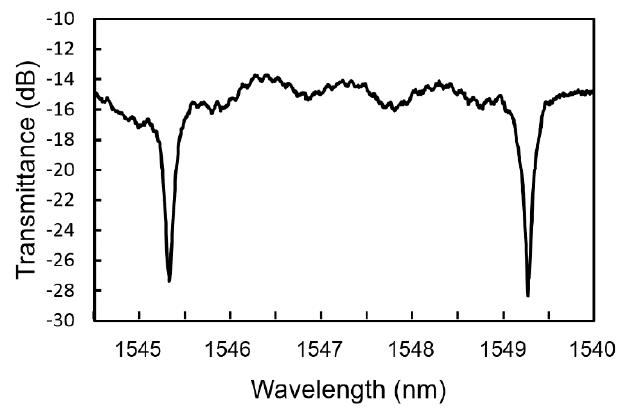
Figure 6. Transmittance spectrum of fabricated Si-MRR.